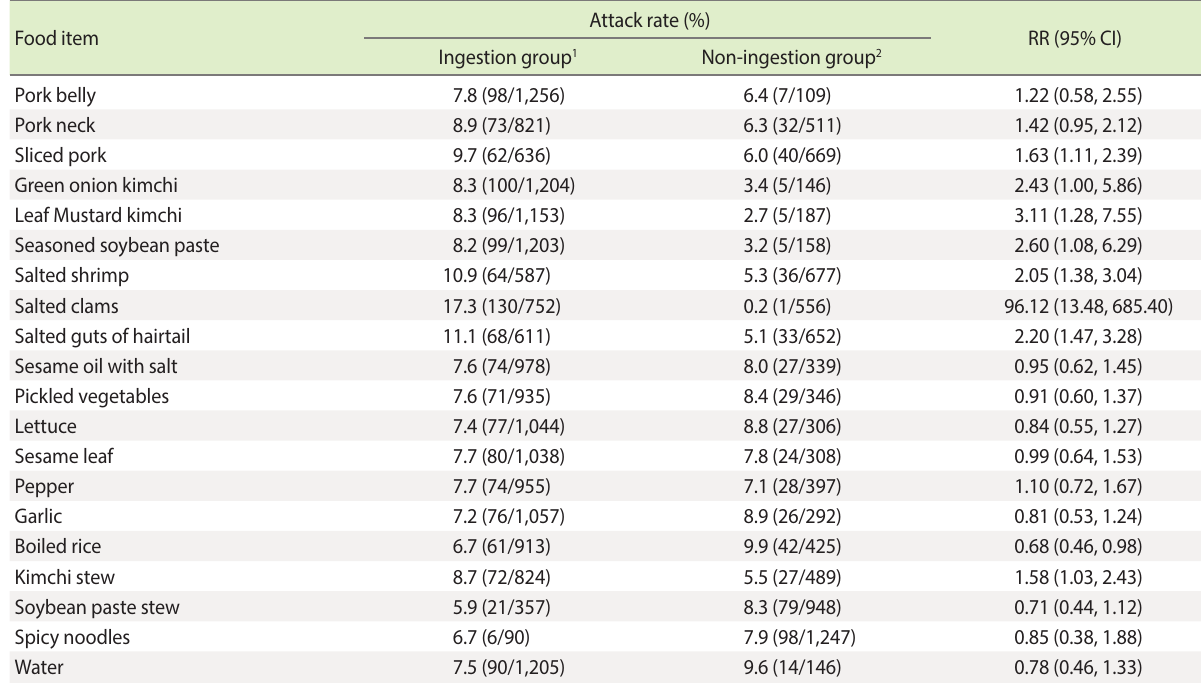
Figure 2. Distribution of date of visit (A) and epidemic curve (B). Table 2. RR for ingestion of each food